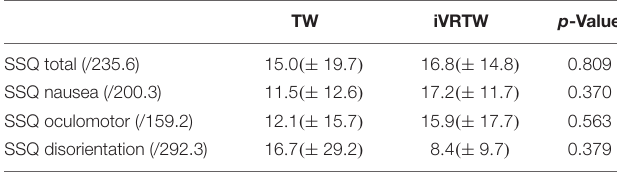
TABLE 3 | Absolute mean values of the Simulator Sickness Questionnaire (SSQ) total and sub scores for the comparison between Treadmill Walking (TW) and immersive Virtual Reality on Treadmill Walking (iVRTW) conditions. TW